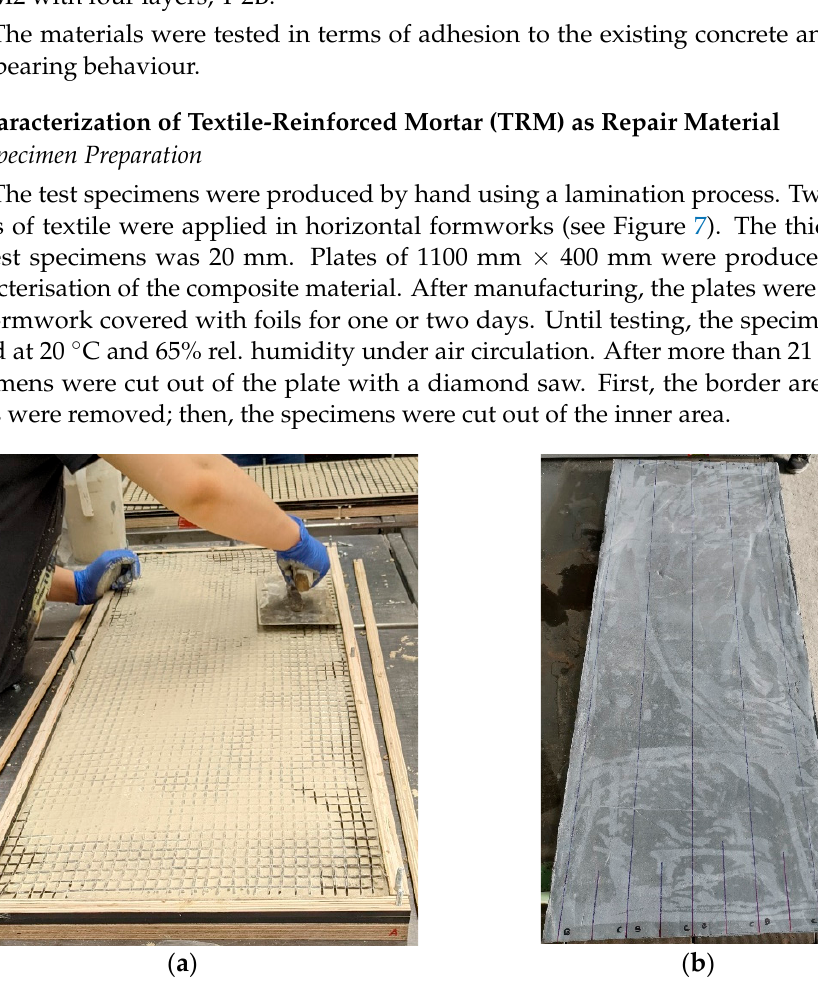
Figure 8. Surface tensile strength (MPa) of the transmission tower pillar (measured on three sides (S); two measuring points one each side) presented as single values.